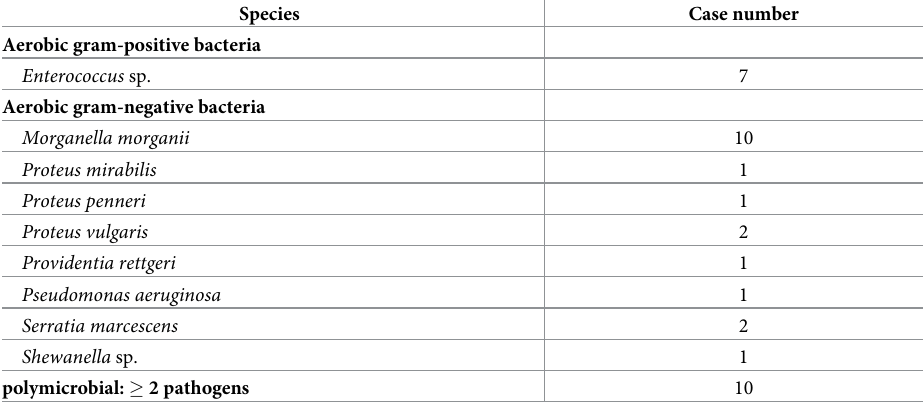
Table 2. Bacteria isolated from infected cobra bite wound culture. Species Case